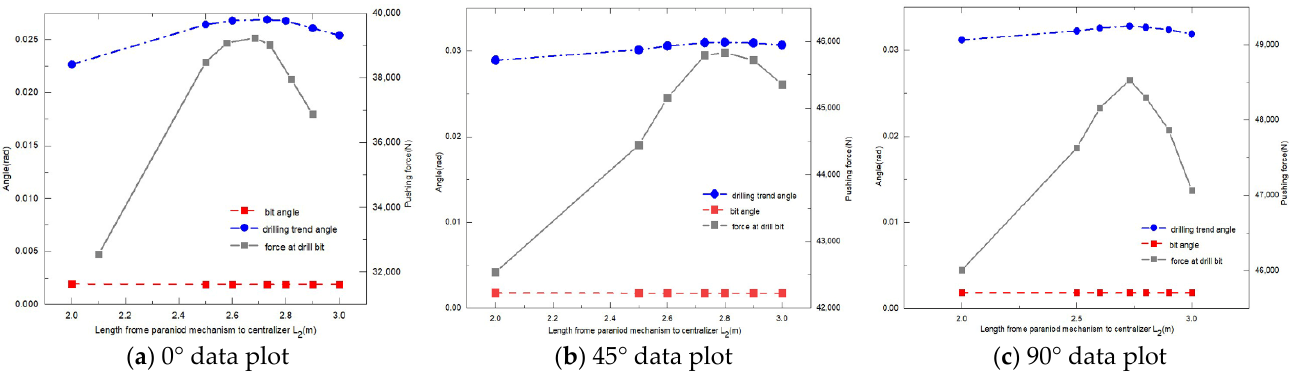
Figure 9. Influence of the length from paranoid mechanism to centralizer (L2) on trajectory control capacity of the tool.